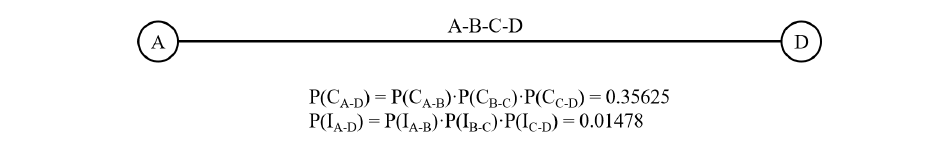
Figure 5. A Single-Channel, Point-to-Point Equivalent of a Single-Channel, Three-Hop Network.